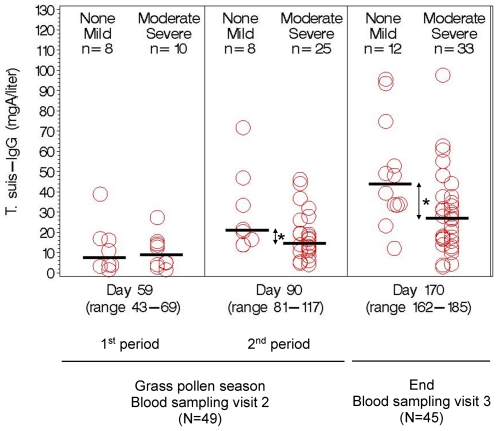
Level of serum IgG against adult T. suis excretory/secretory antigen over time according to severity of gastrointestinal symptoms after three-weekly ingestion of infective T. suis eggs by 49 subjects in a randomized placebo-controlled double-blind clinical trial in grass-pollen allergic adults, Denmark 2008.Within subgroups of severity, data circles are positioned by severity (None, left; Mild, right), (Moderate, left; Severe, right). Blood was drawn times 3 (blood visit 1 at start (not shown, no IgG response)), blood visit 2 during grasspollen season (1st period and 2nd period), and blood visit 3 at end of study), and diary was kept day 0–168, except in 4 subjects indicated by circles in figure A: 2 subjects (severe) dropped out (moved abroad, no time) between blood visit 2 (day ∼90) and 3, however recorded diary until day ∼90; 2 other subjects (moderate, severe) recorded diary until blood sampling visit 2 (day ∼59) or longer (>day 90) although they did not attend blood visit 3. * P<0.05.